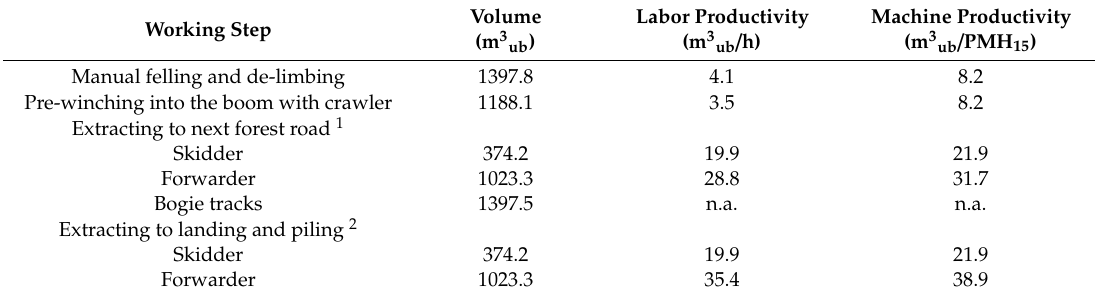
Table 8. Resulting productivity of the di ff erent working steps in the ground-based